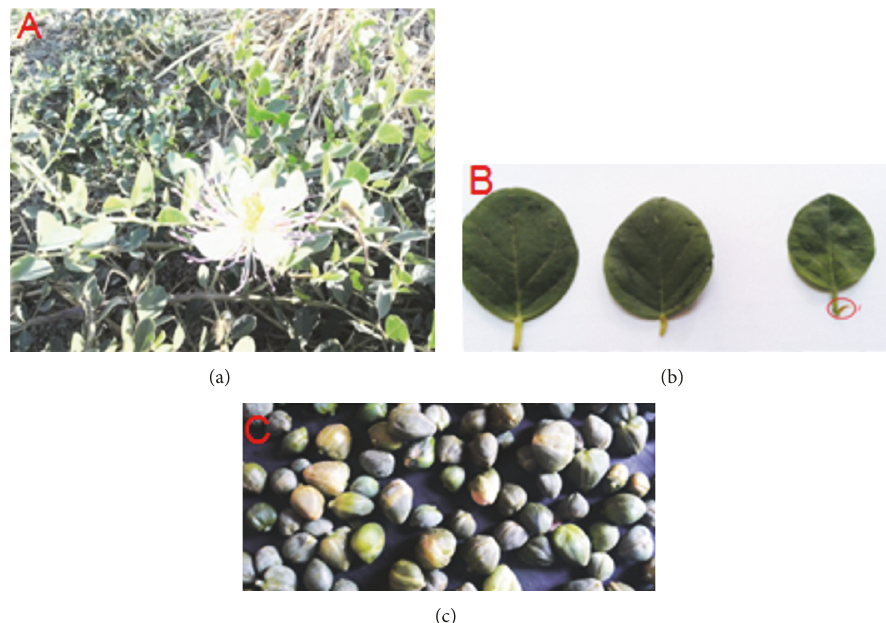
Figure 2: Different parts of Capparis spinosa studied: (a) plant, (b) leaves, (c) and